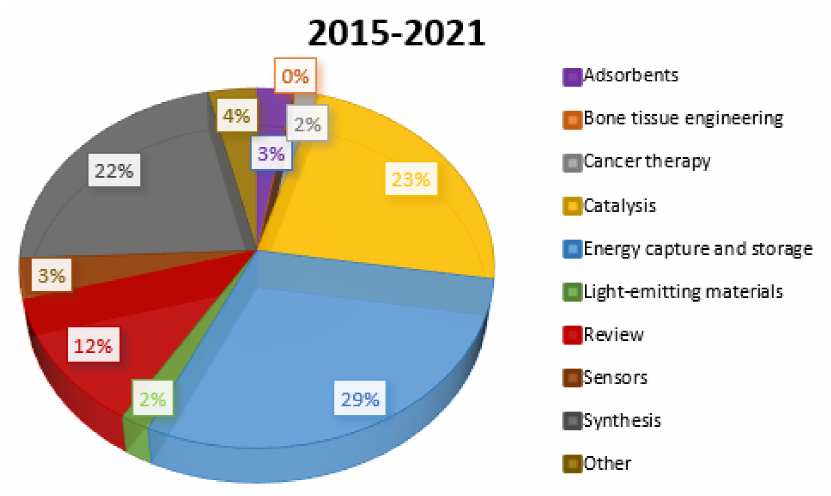
Figure 4. Applications of biotemplating in different fields from 2015 to June 2021. Source: Scopus, searching biotemplating or